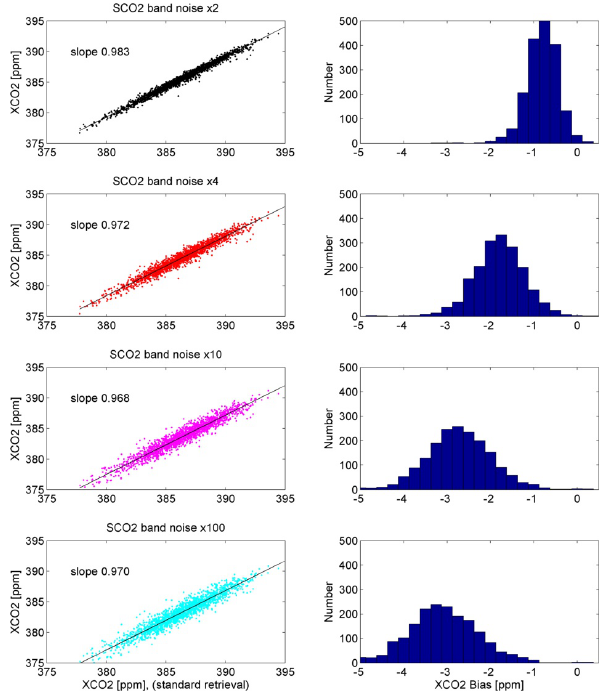
Fig. 12. Histograms of the bias in retrieved X CO for different scal- 2 ing factors of the noise in the strong CO 2 band. The bias is the difference between X CO retrieved with amplified noise and with 2 standard